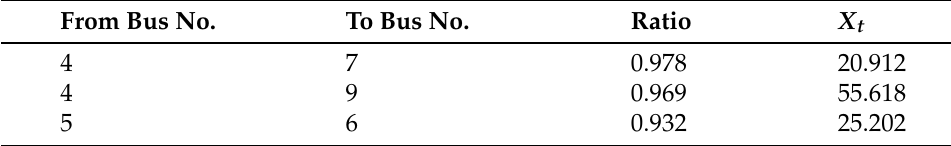
Table 5. Reactance and tap of transformers (%).